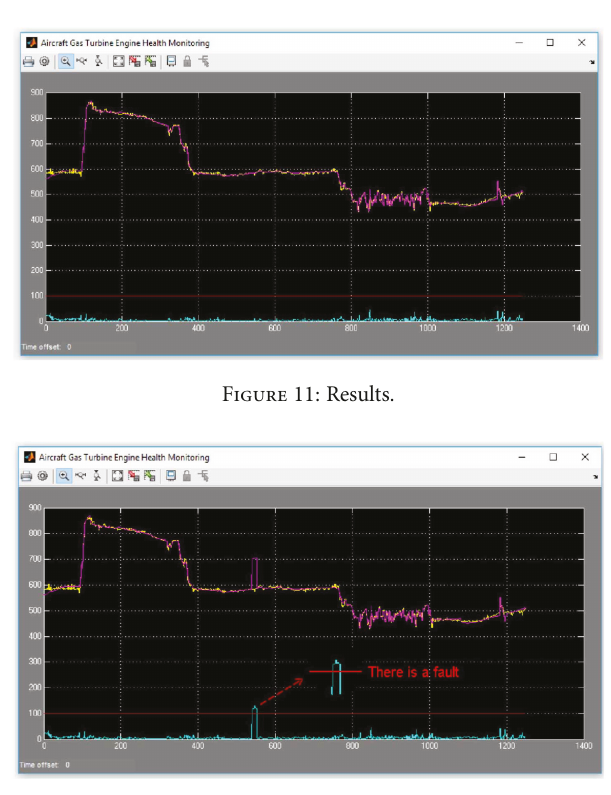
Figure 12: Graphical representation of an unusual EGT